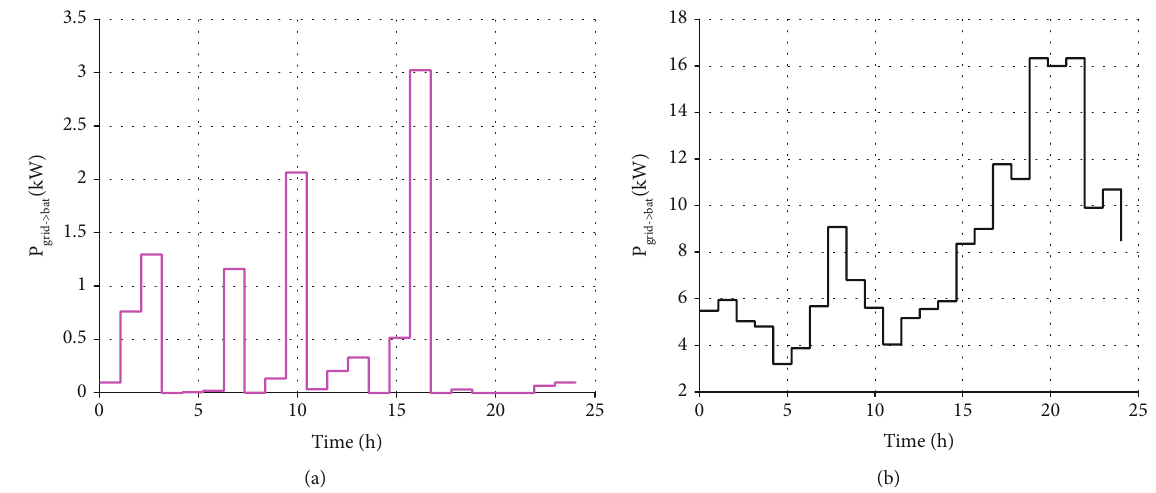
Figure 21: (a, b) Discharged power from the grid to the battery and load by the hybrid algorithm,